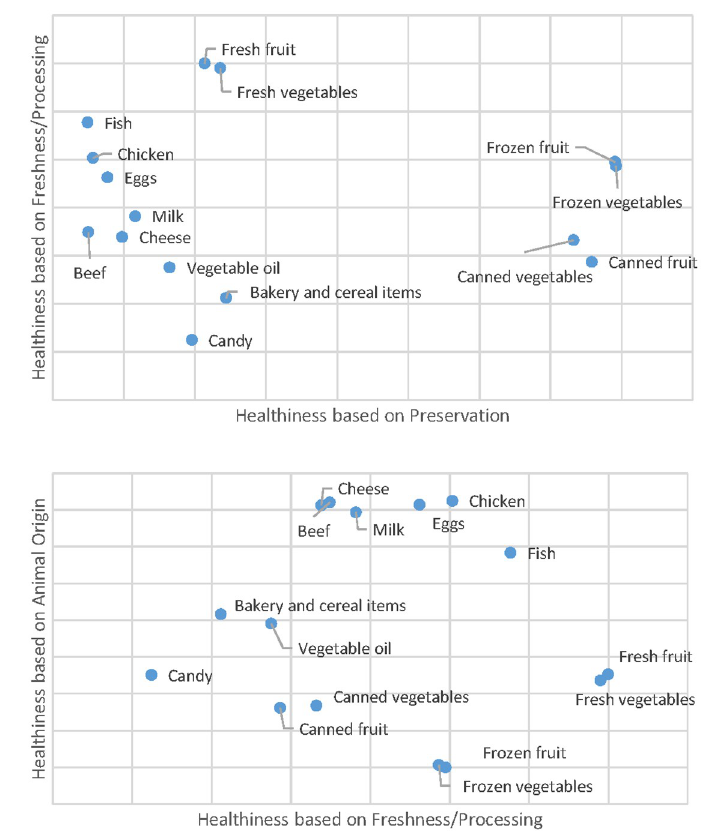
Fig 3. Three dimensions of 15 food’s healthiness (Factor loadings from promax